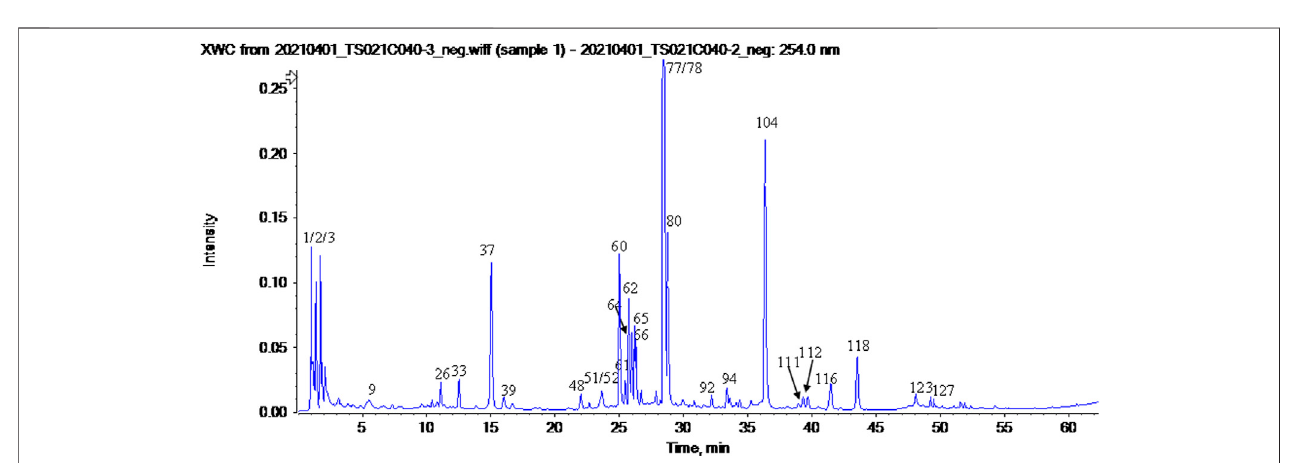
FIGURE 6 | The UV chromatogram of NFPX in 254